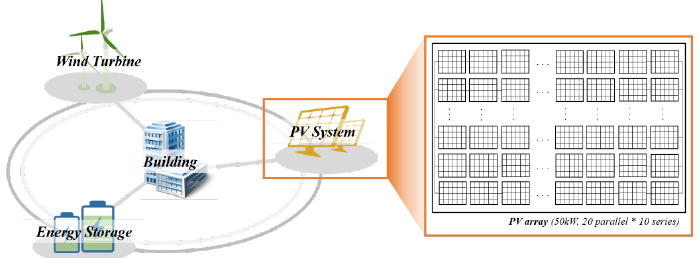
Figure 2. Schematic diagram of grid-connected PV